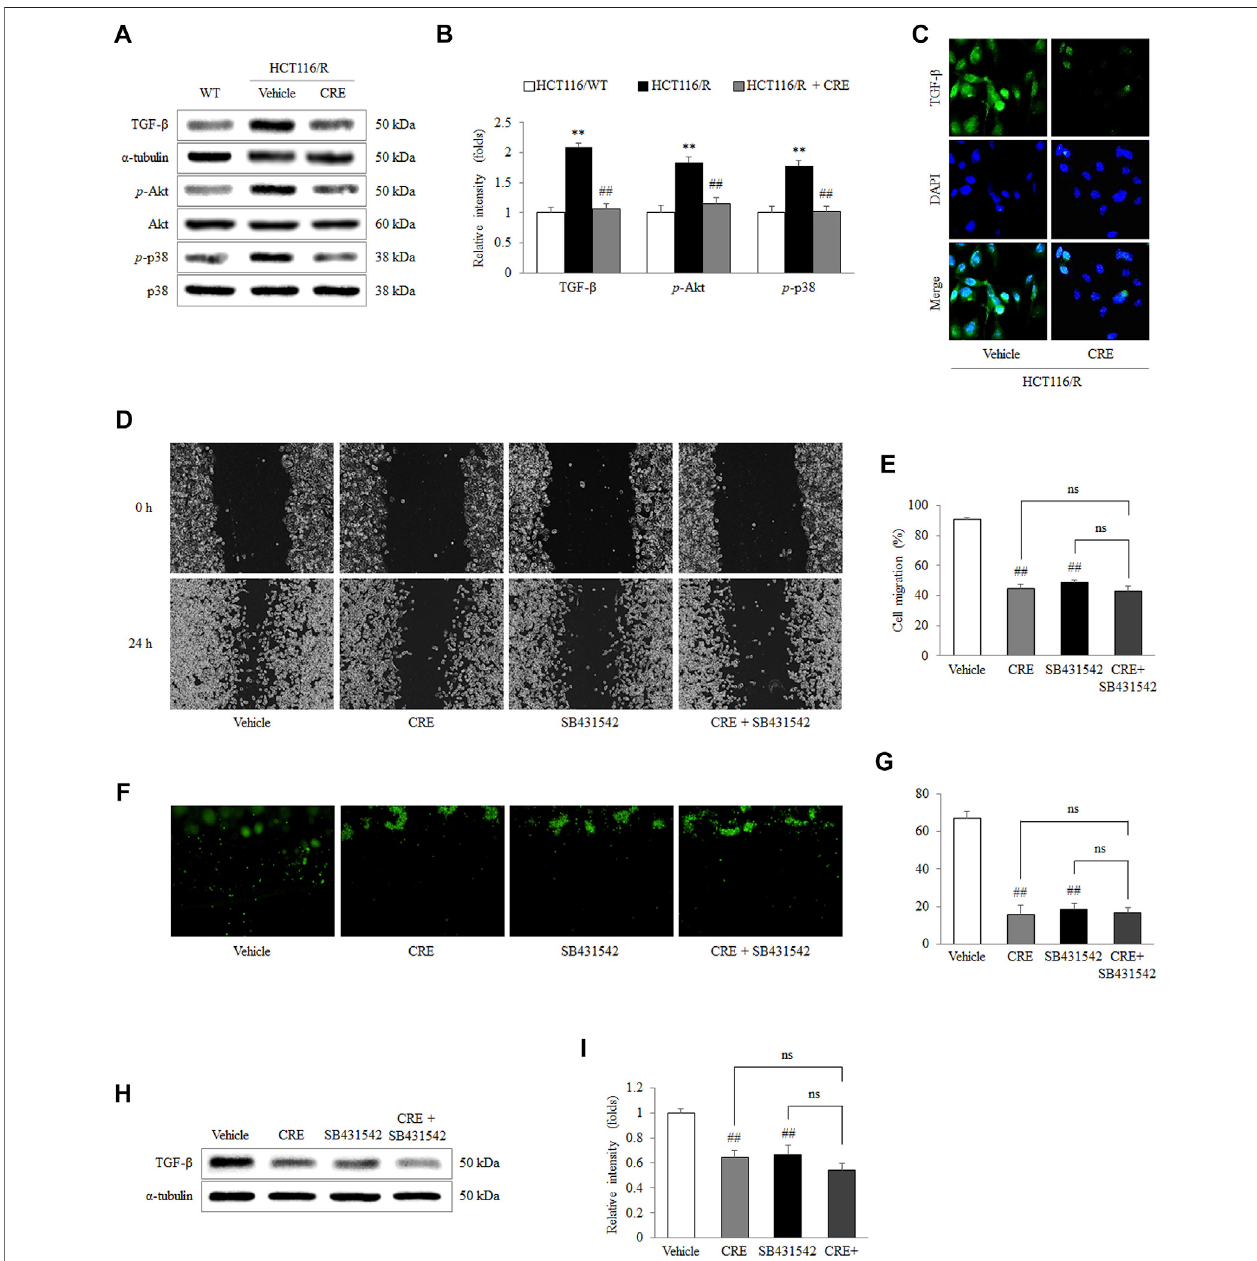
FIGURE5| CRE inhibited EMT via TGF- β signaling.Theexpression levels ofTGF- β noncanonicalpathway-related proteins andthecorrespondingintensities were quanti fi ed (A,B) .Thelevel ofTGF- β inHCT116/RcellstreatedwithCREwasvisualized under fl uorescence microscopy (C) .Theeffects ofCRE (20 μ g/ml)with/withouta TGF- β inhibitor (SB431542) on cell migration were analyzed in a wound-healing assay (D,E) and 3D invasion assay (F,G) . The protein level of TGF- β in HCT116/R cells treated with CRE with/without SB431542 was quanti fi ed by western blot (H) , and the corresponding intensities were quanti fi ed (I) . The data are expressed as the mean ± SD value ( n = 3). ** p < 0.01, compared to HCT116/WT cells. ## p < 0.01 compared to HCT116/R cells.